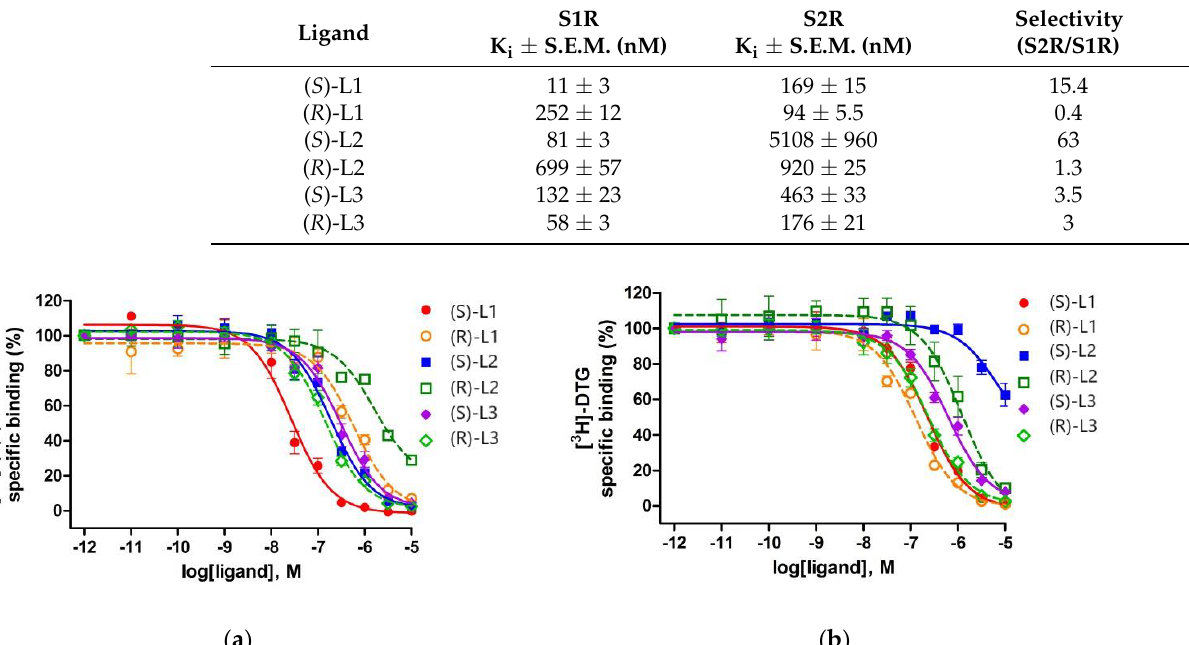
( c ) Figure 5. Comparison of the binding poses of the ( S ) (gold) and ( R ) (green) enantiomers of the highest ranked new S1R ligands ( a ) L1, ( b ) L2, and ( c ) L3. The binding pose of (+)-pentazocine (red) is also shown.